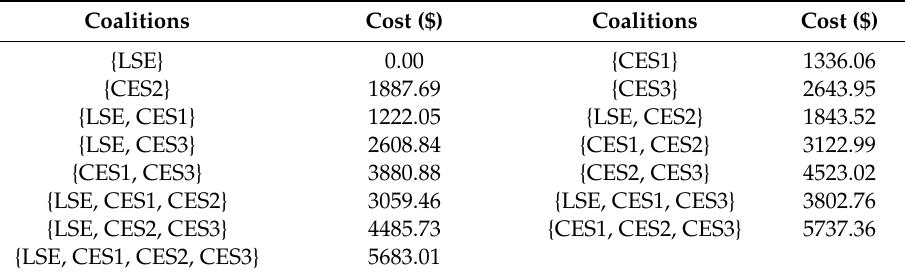
Table 2. Costs of various coalitions.